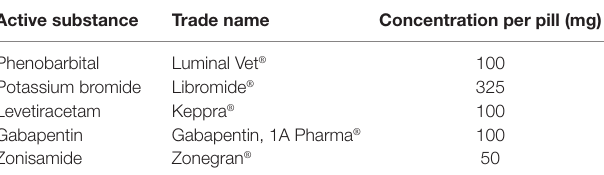
TaBle 2 | antiepileptic agents unsed in patch tests.